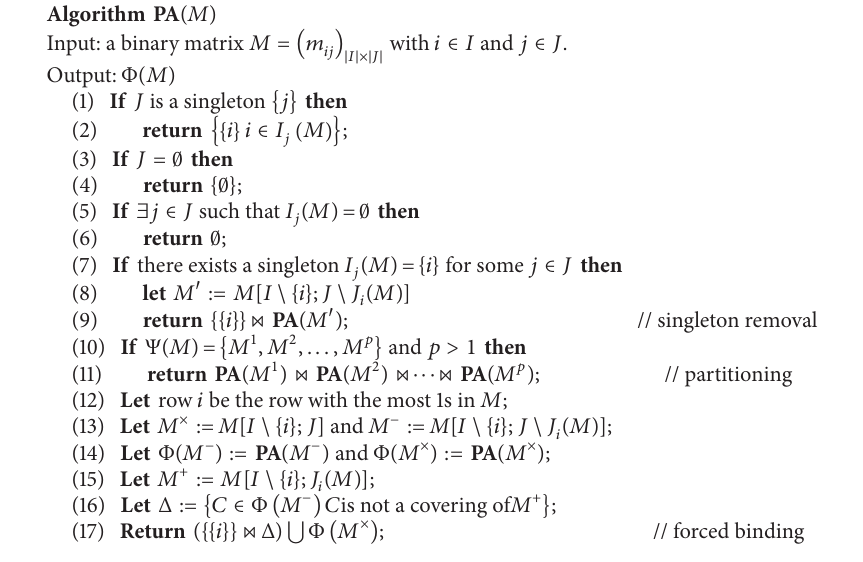
Algorithm 1: Algorithm for finding all irredundant